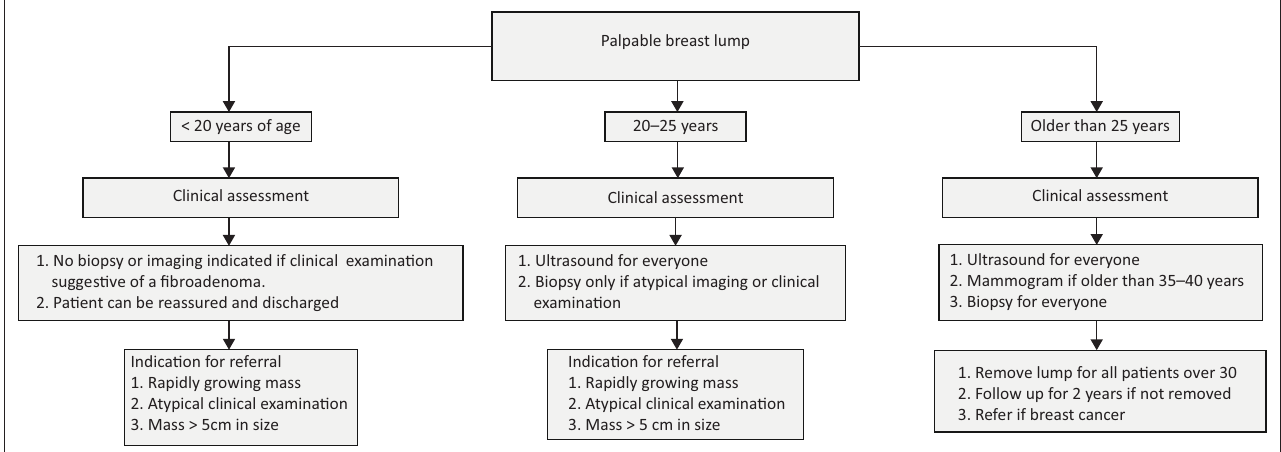
FIGURE 1: Algorithm for the management of palpable breast lumps based on the age of the